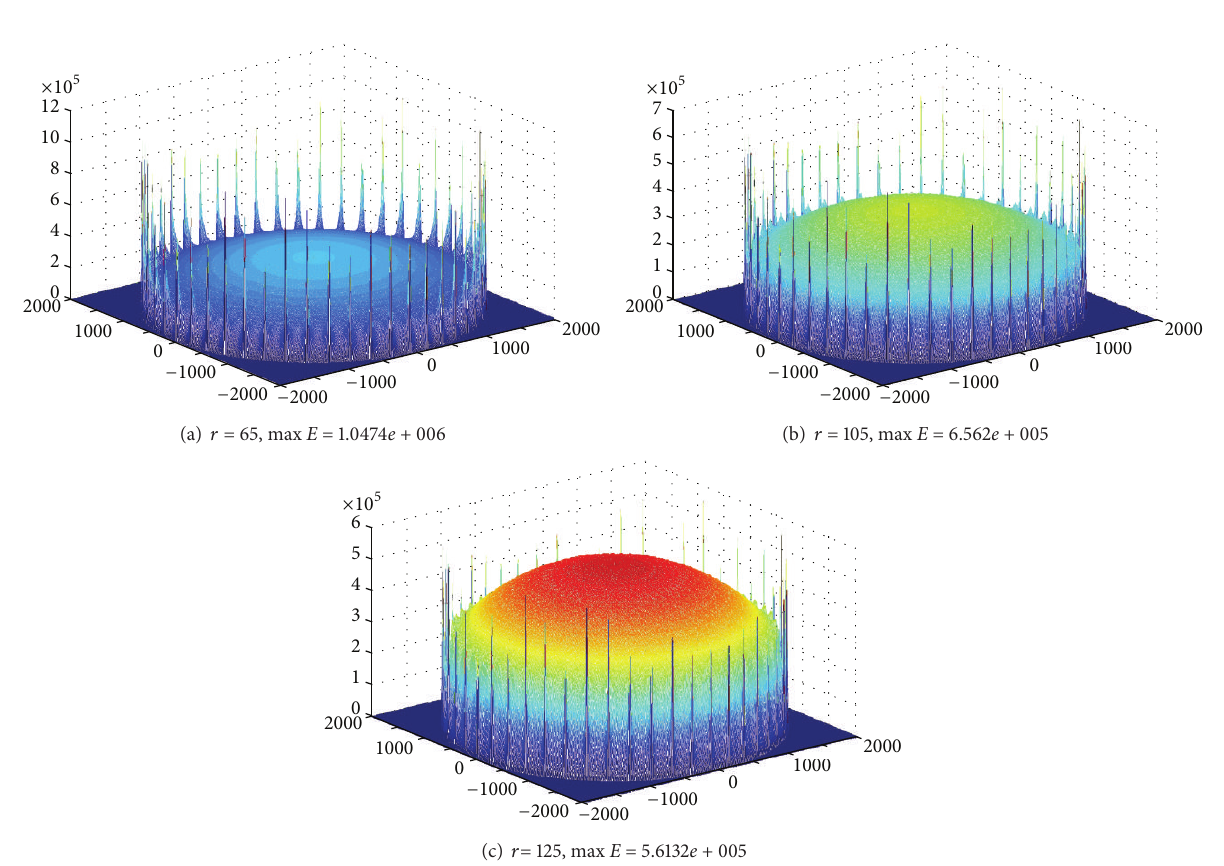
Figure 13: The largest energy consumption of mobile sink network under different 𝑟 ( 𝑅 = 2000 m, 𝑅 𝑚 = 2000 m, rounds = 50, anchors =